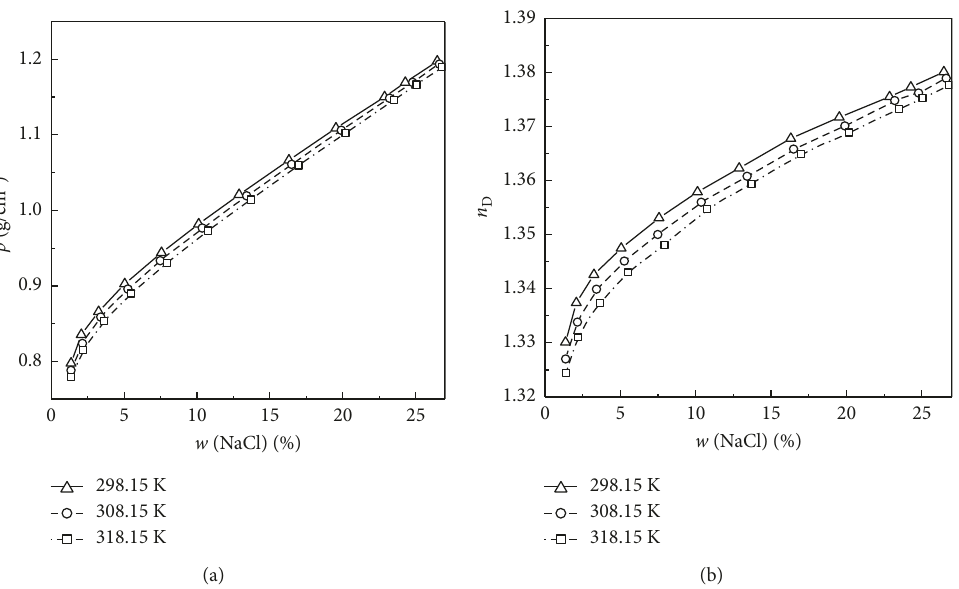
Figure 6: Comparison of the physicochemical properties versus sodium chloride content for the ternary system (NaCl + CH 298.15, 308.15, and 318.15K; ( △ ), experimental point at 298.15K; ( ○ ), experimental point at 308.15K; ( □ ), experimental point at 318.15K: (a) density versus NaCl composition; (b) refractive index versus NaCl composition.